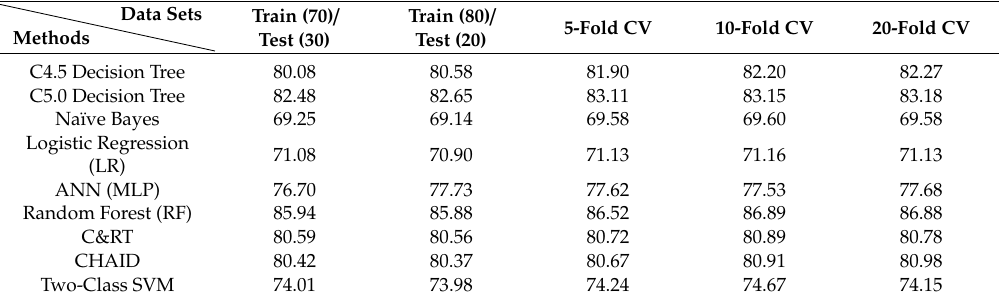
Table 4. Prediction accuracy of stroke with quartile and CFS